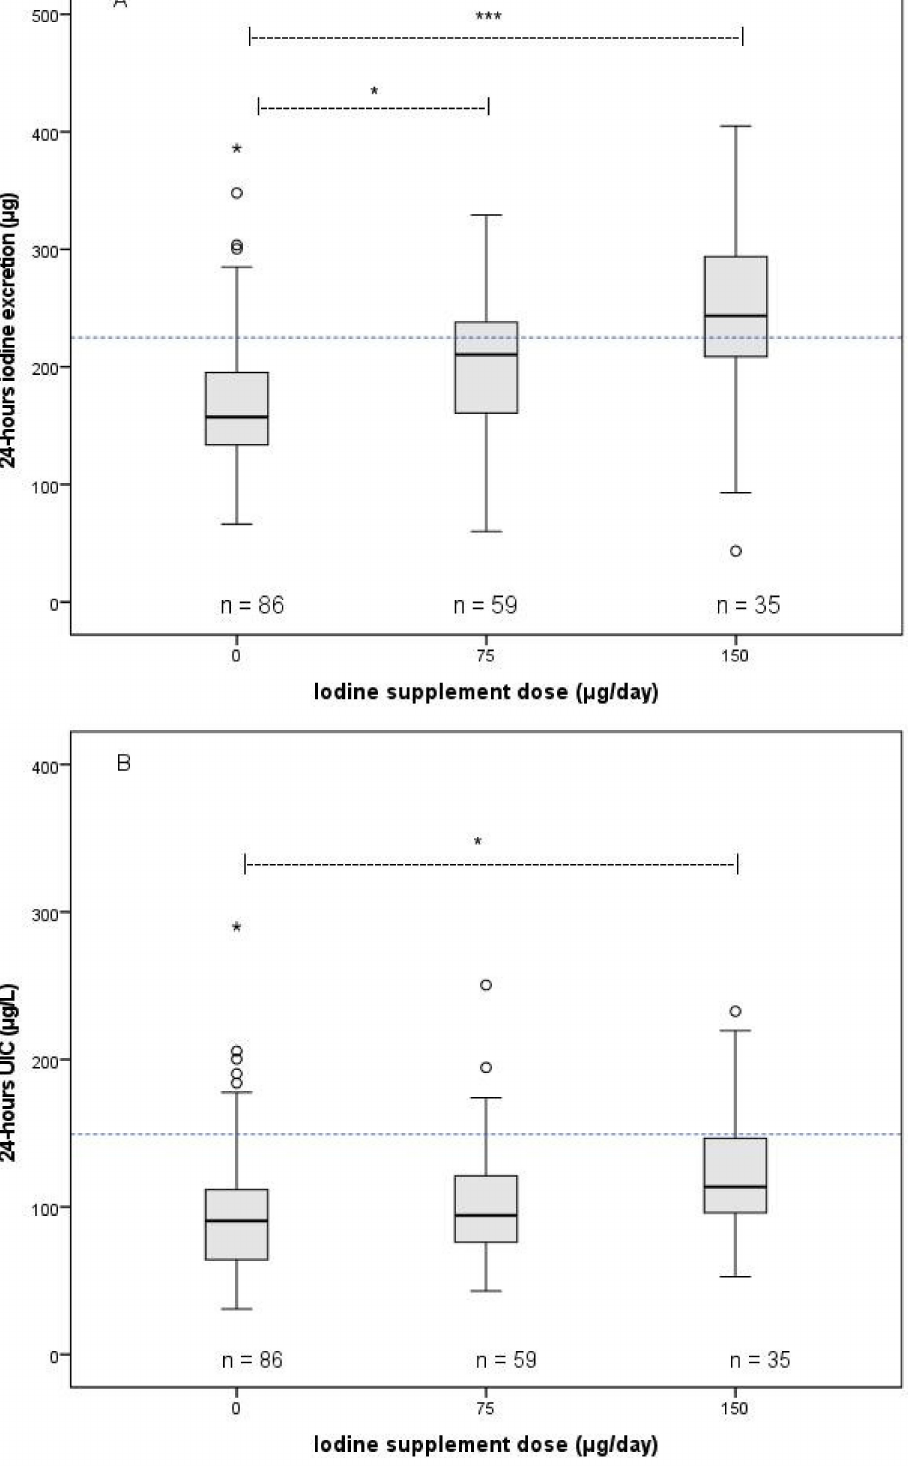
Figure 1. Iodine excretion in 24 h urine (panel ( A ); in µ g) and 24 h UIC (panel ( B ); in µ g/L) of pregnant JOZO participants in relation to the reported iodine supplement dose. Cut-off values in panel A: 225 µ g and panel B: 150 µ g/L. These cut-off values are used for populations, not individuals. * p < 0.05, *** p ≤ 0.001. Dose 0: pregnant participants who did not use nutritional supplements (n = 32) + counterparts who used supplements but without iodine (n = 54). For clarity, two subjects with excessive iodine status (see text) were not included in the figures. Abbreviation: UIC, urine iodine